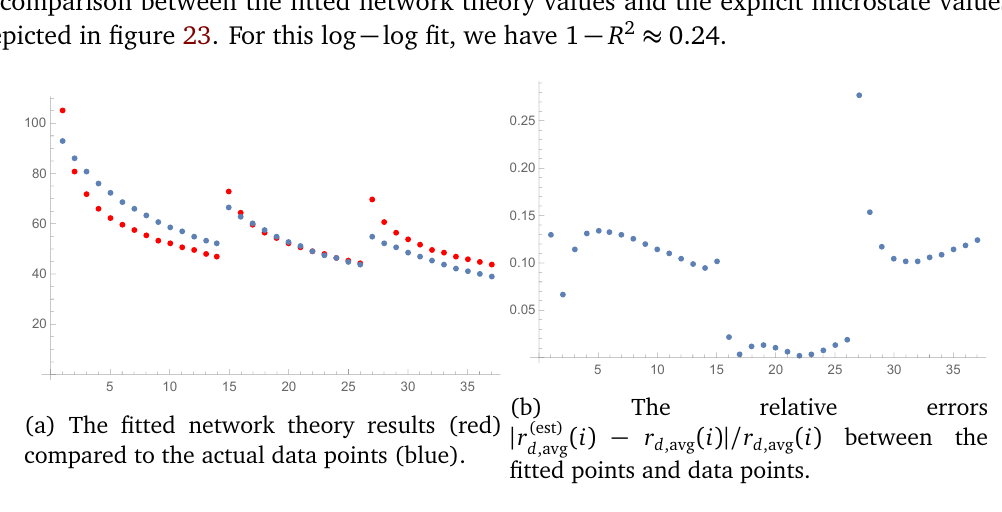
Figure 23: Comparison of the data points and the